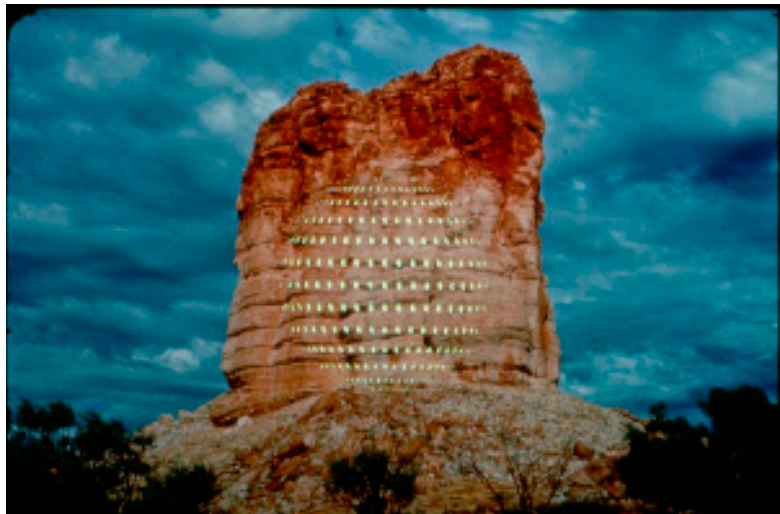
Figure 22. One of Ostoja’s landscapes with CGI. Published with permission. Image courtesy of the State Library of South Australia. SLSA: PRG 919/21/64.